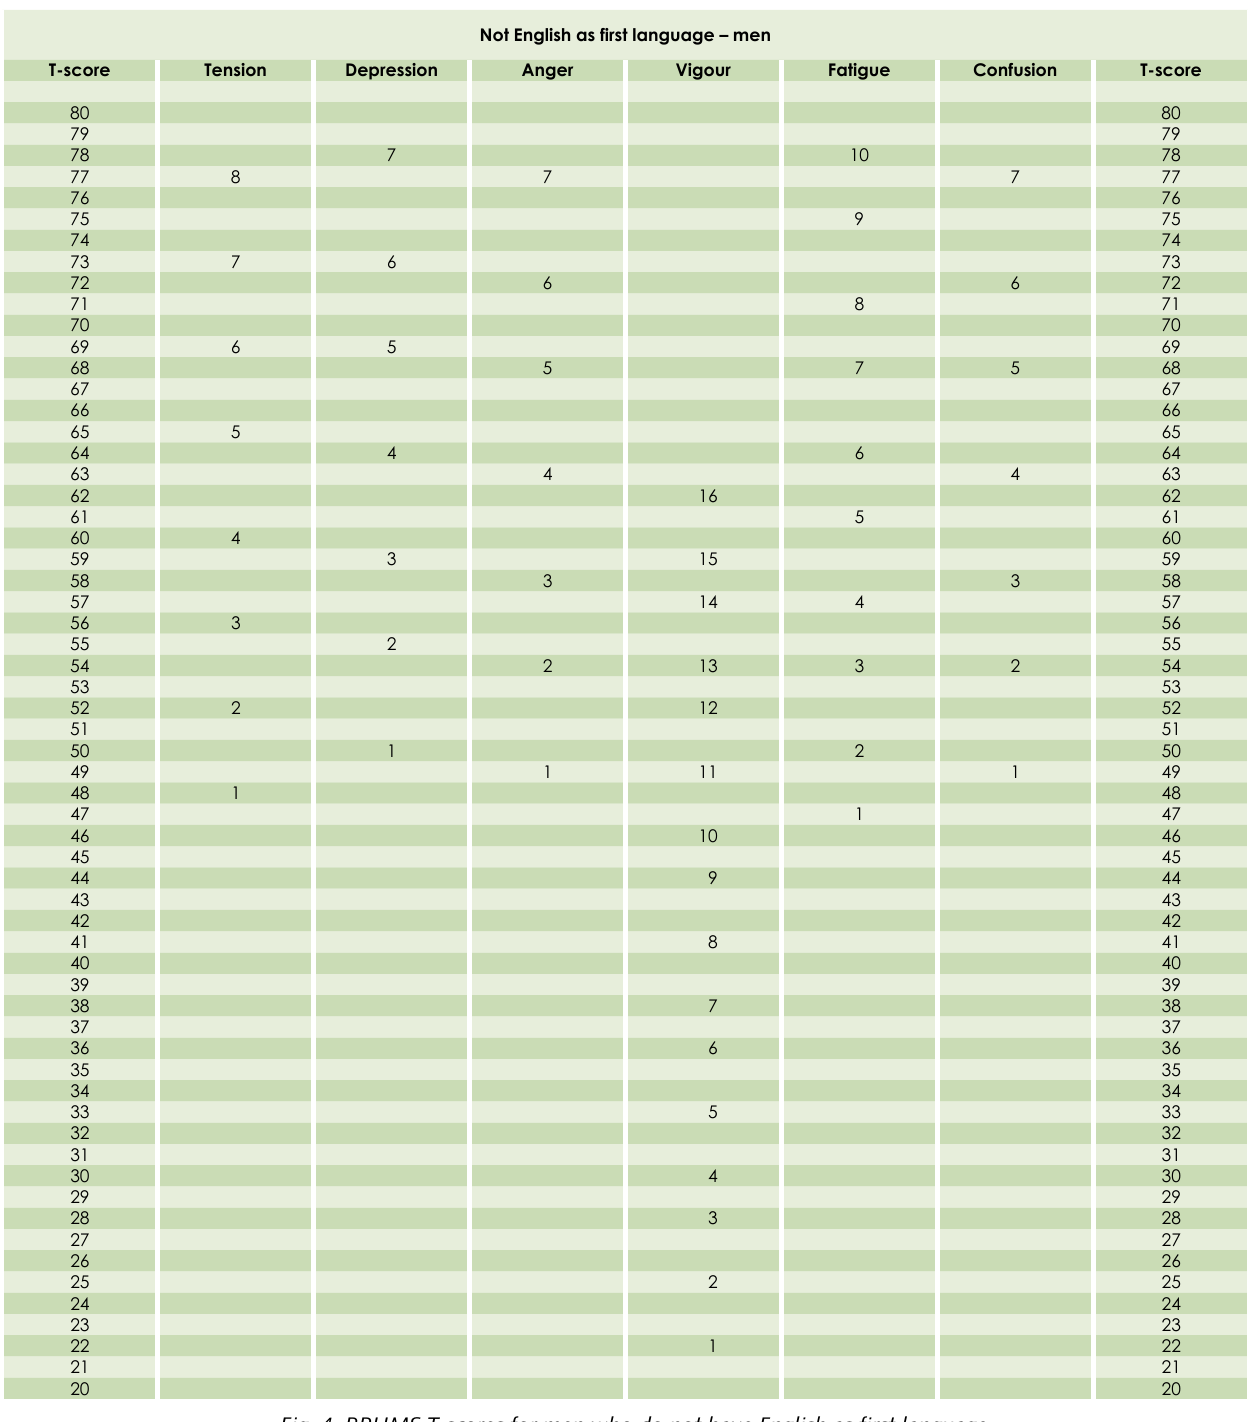
Fig. 4. BRUMS T-scores for men who do not have English as first